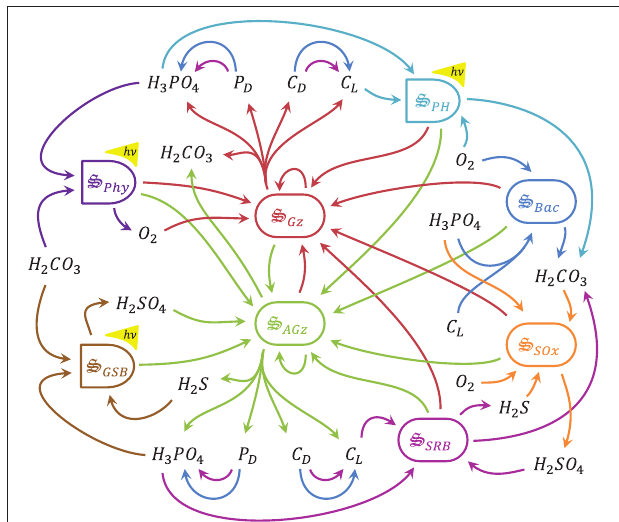
FIGURE 1 | Schematic of catalysts and associated reactions used in the MEP model for Siders Pond. Functional groups include: S Phy , phytoplankton, purple, 2 rxns; S GSB , green sulfur bacteria, brown, 2 rxns; S Gz , aerobic grazers, red, 8 rxns; S AGz , anaerobic grazers, green, 8 rxns; S Bac , aerobic organoheterotrophic bacteria, blue, 3 rxns; S SRB , sulfate reducing bacteria, magenta, 3 rxns; S PH , photoheterotrophs, cyan, 1 rxn; S SOx , sulfide oxidizing bacteria, orange, 1 rxn. Other abbreviations: h ν , photon capture; C L , labile organic carbon; C D , refractory organic carbon; P D , refractory organic phosphorous. See Table 2 for qualitative representation of functional reactions and section 2.7 of the Supplementary Material for stoichiometrically balanced